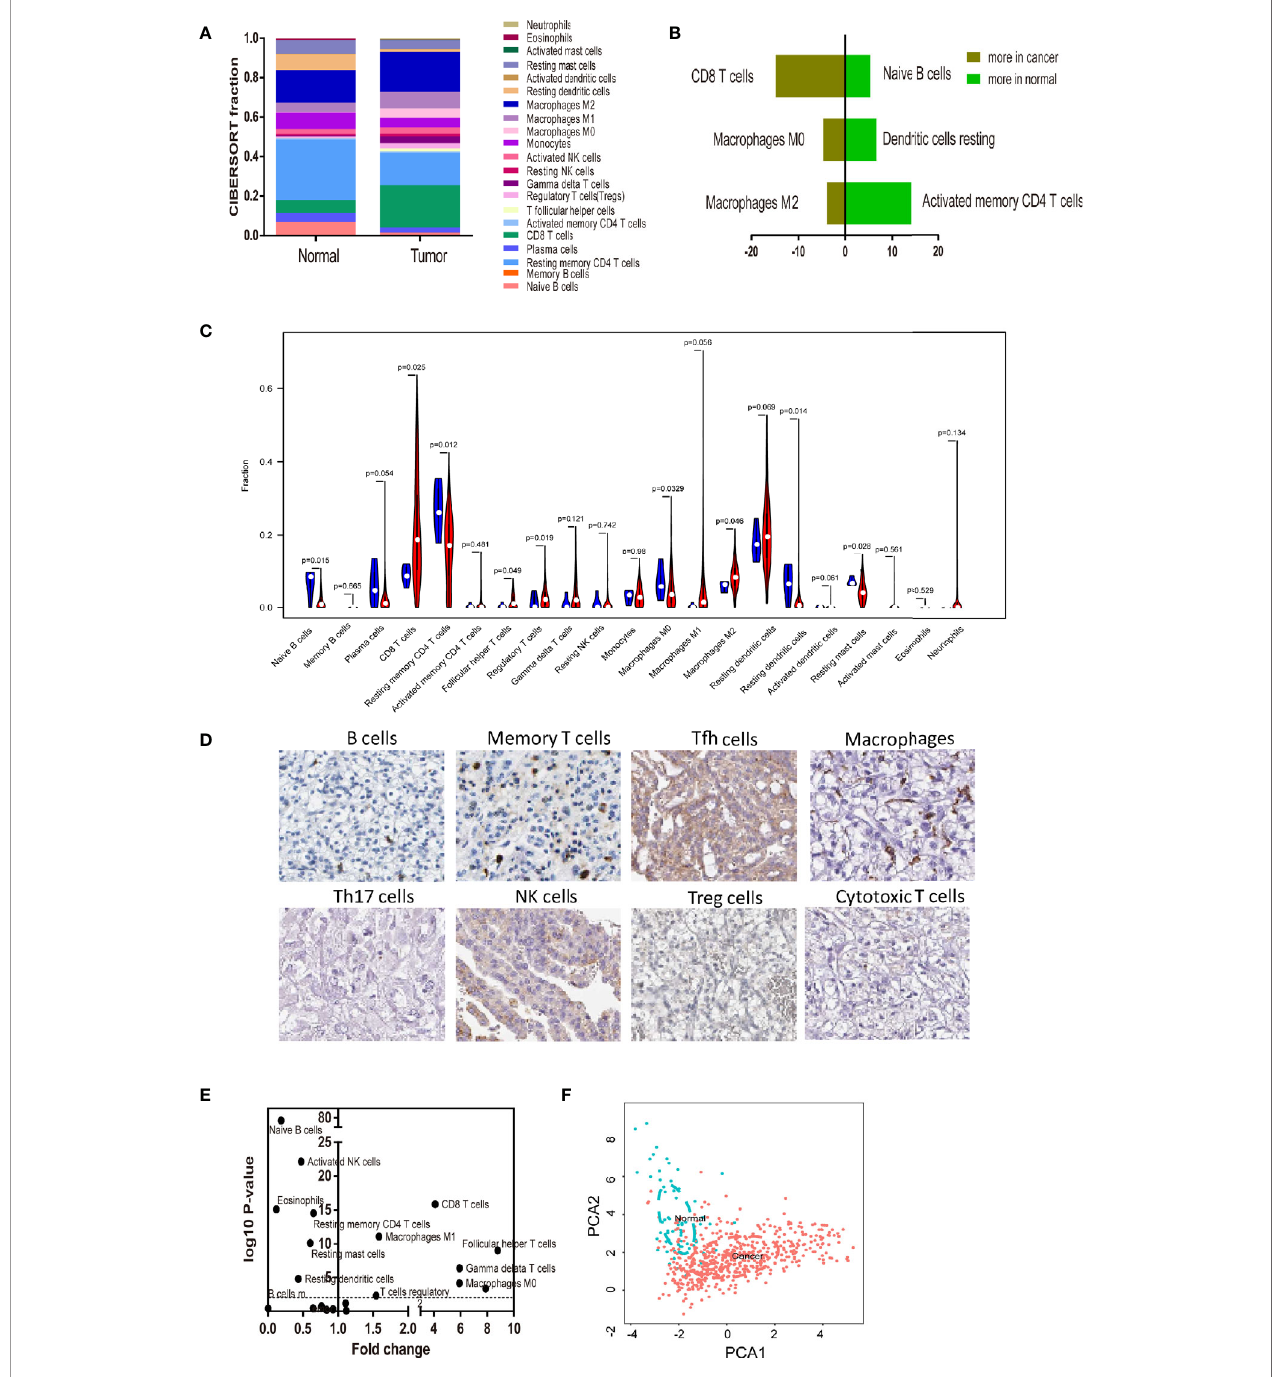
FIGURE 2 | Landscape of microenvironment TIICs composition in RCC. (A) Relative microenvironment TIICs proportions in normal and RCC tissues. (B) Quanti fi ed changes of in fi ltrating immune cell composition in normal and RCC tissues. (C) Violin plot of the proportions of TIICs subpopulation. (blue represents normal tissue, red represents RCC). (D) Immunohistochemical stainings showed that the expression trends of different levels of speci fi c immune cells. (E) Volcano Plot visualizing the differentially in fi ltrated immune cells. (F) Principal components analysis (PCA) analyzed all RCC samples. The proportions of immune cells from normal and RCC displayed distinct group- bias clustering and individual differences by